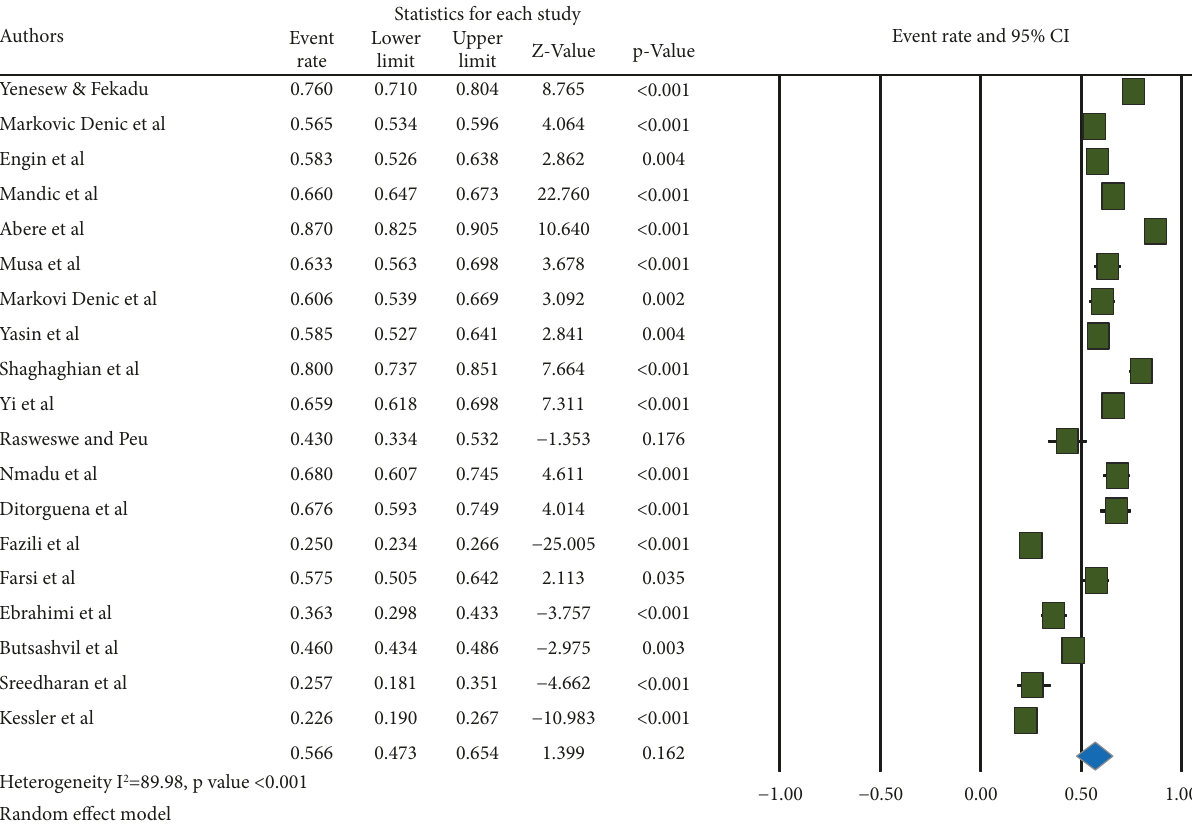
Figure 6: Overall pooled prevalence of occupational exposure to blood and body fluids in career time among healthcare